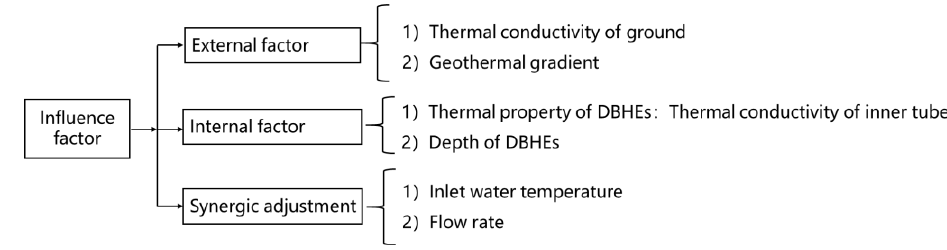
Figure 11. Heat transfer per length of the DBHE.